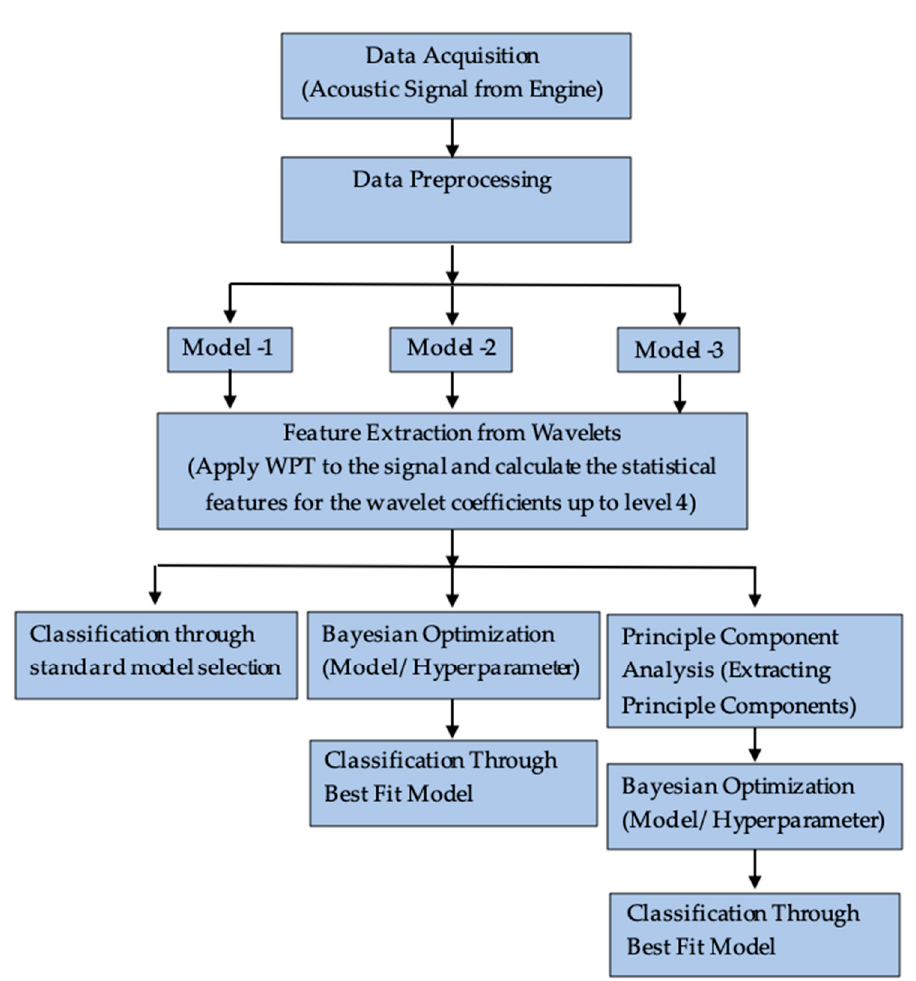
Figure 4. Workflow of the methodology and the comparisons for engine fault diagnosis.